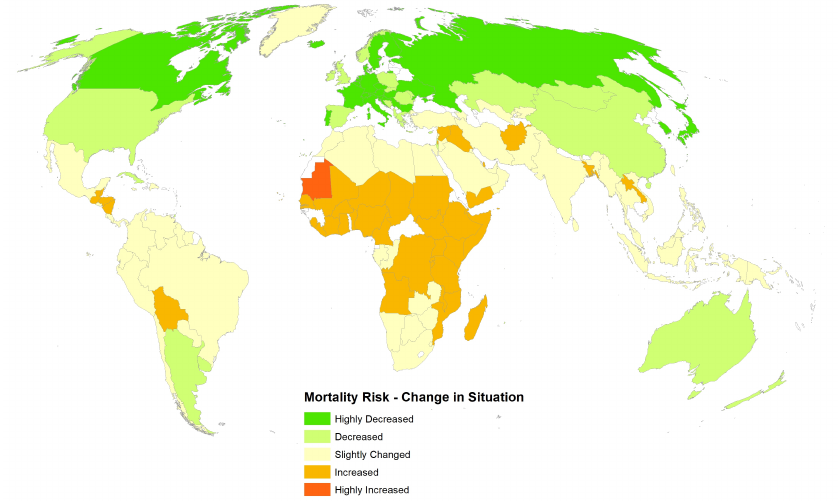
Figure 3. Change in risk where each country had its change of risk normalised onto a range of 1–5, where 1 indicates highly decreased risk and 5 indicates highly increased